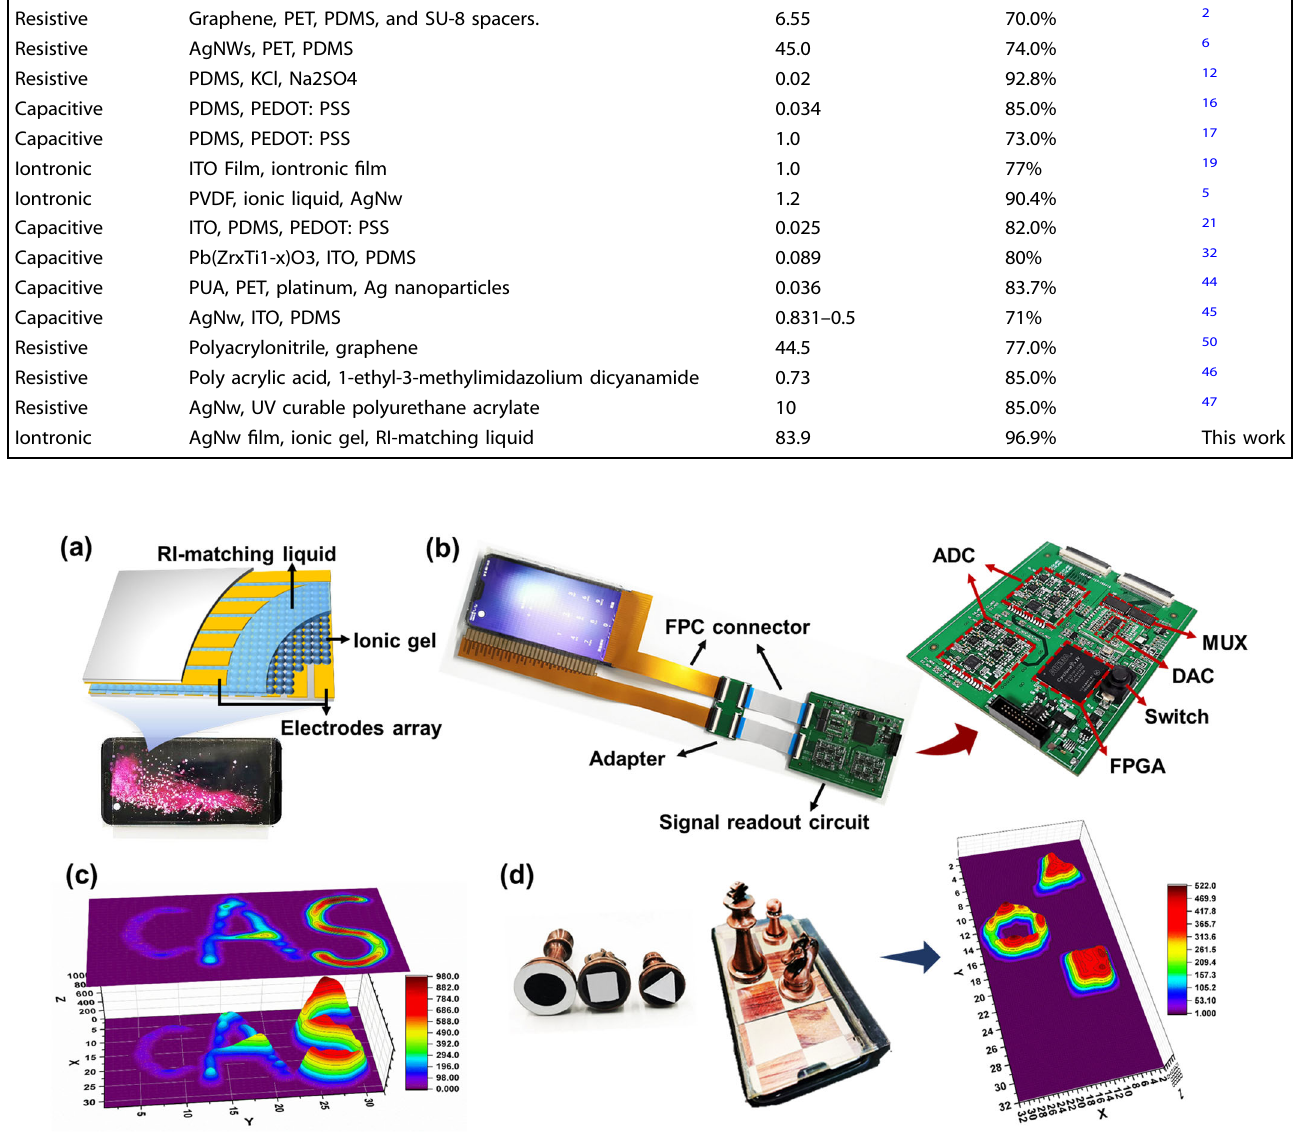
Table 1. The detailed performance speci fi cations of the transparent pressure sensors cited in Supplementary Fig. 6.